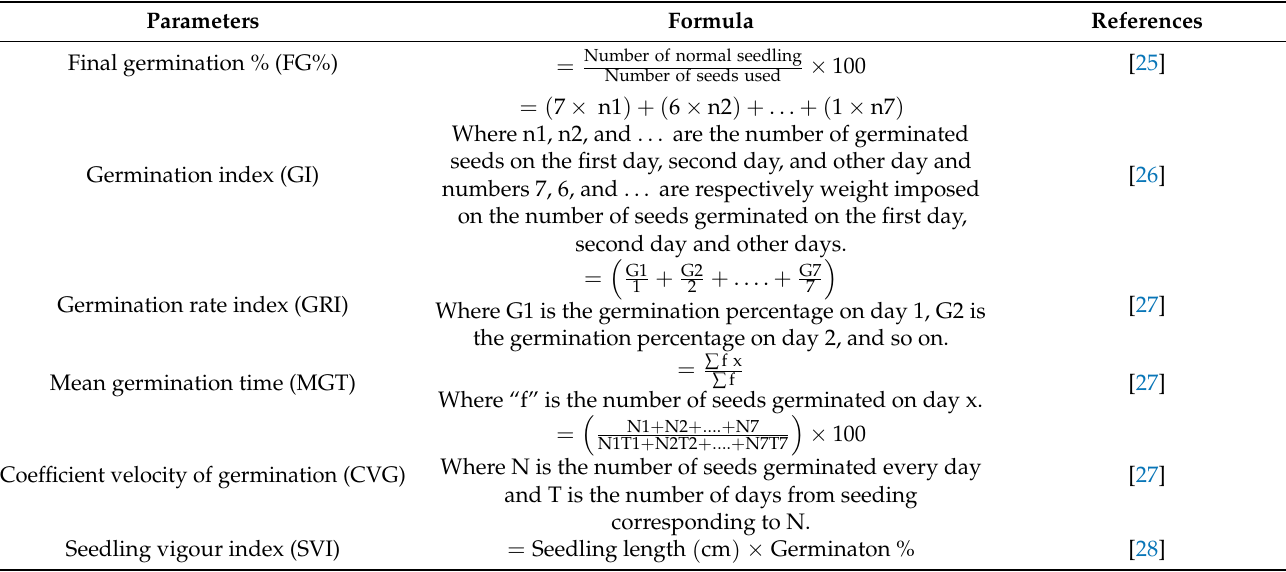
Table 2. Formulas for the calculation of germination related